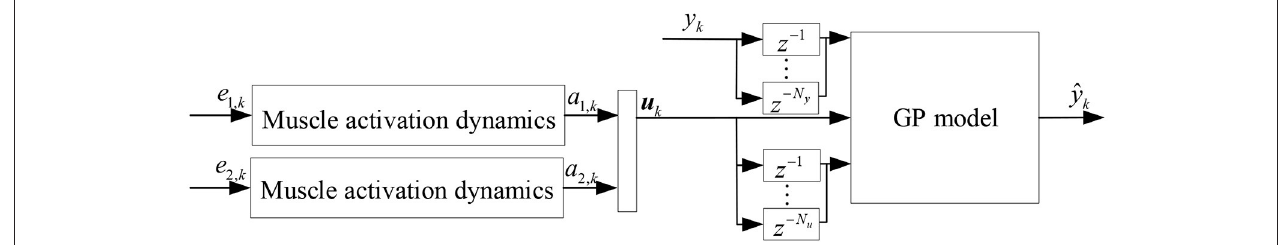
FIGURE 3 | Joint angle prediction based on Gaussian process autoregressive